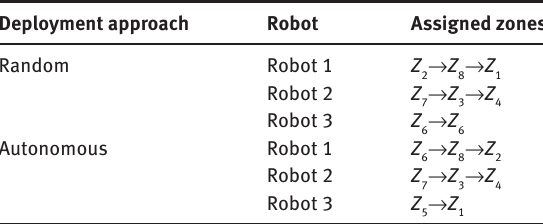
Table 4: Assigned Areas for the Scenario with Three